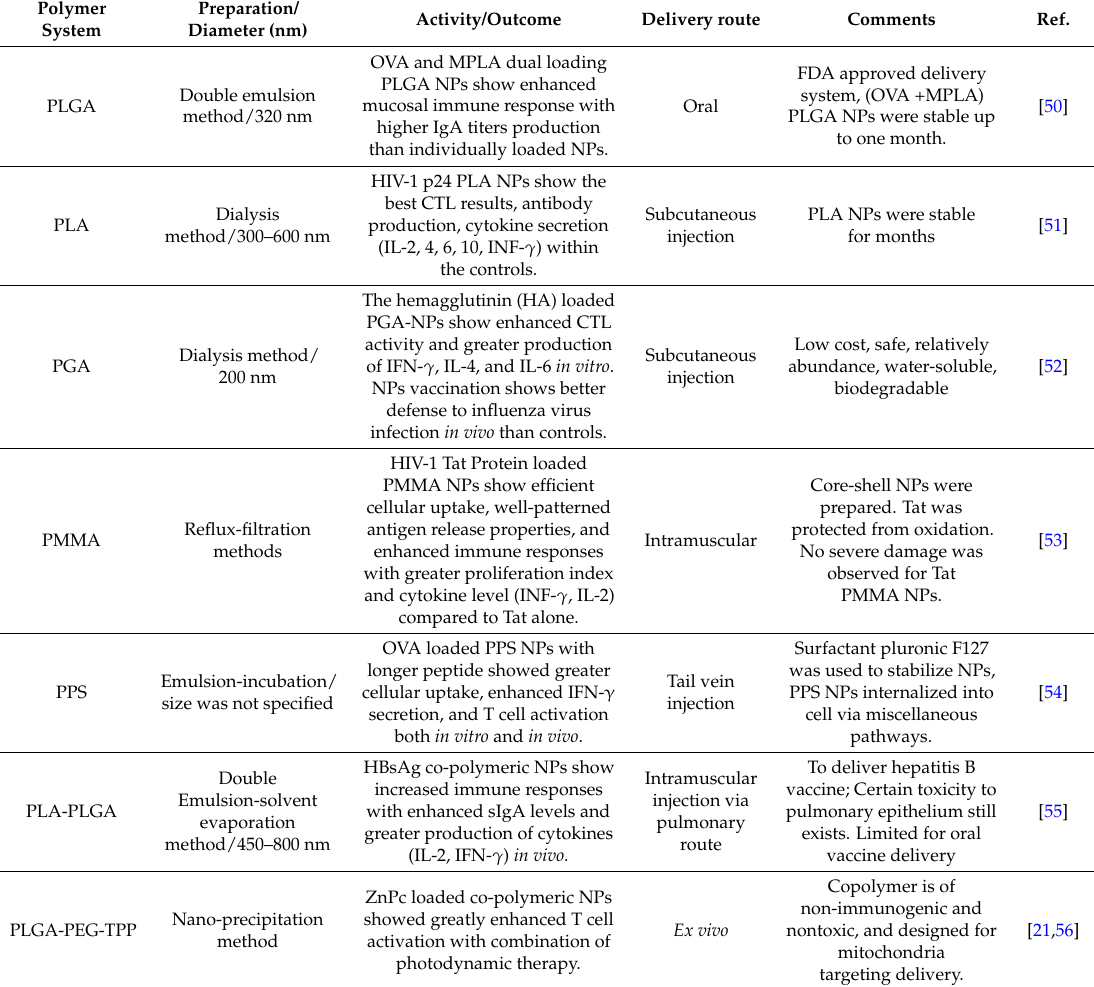
Table 2. Polymeric NP based antigen delivery